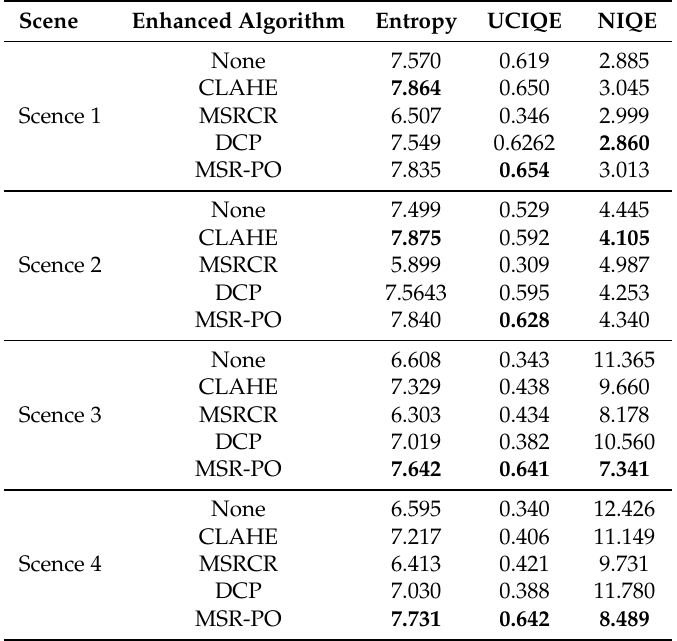
Table 1. Objective assessment index of underwater image